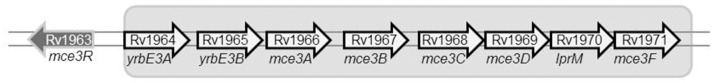
Diagram showing the location of the gene mce3R within the mce3R operon.